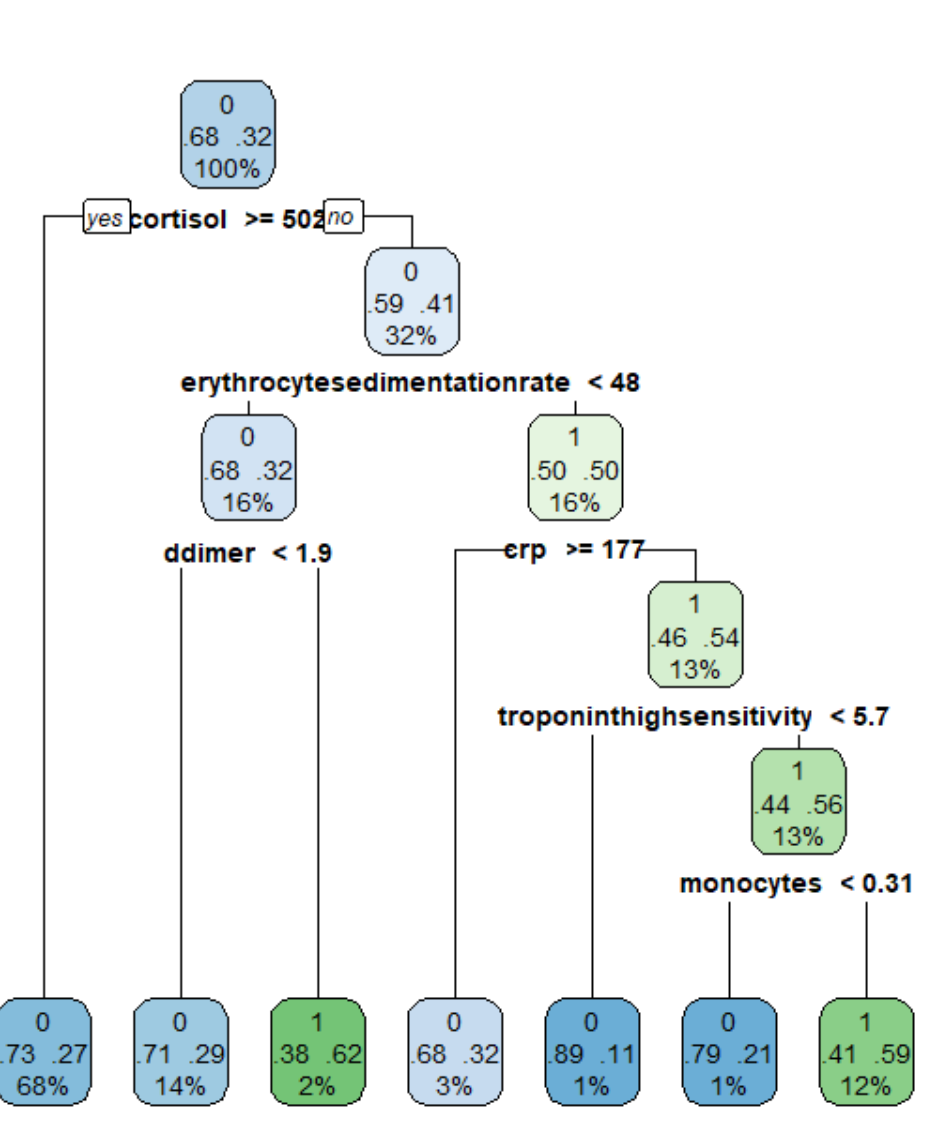
Figure 15. Decision tree structure for COVID-19 risk